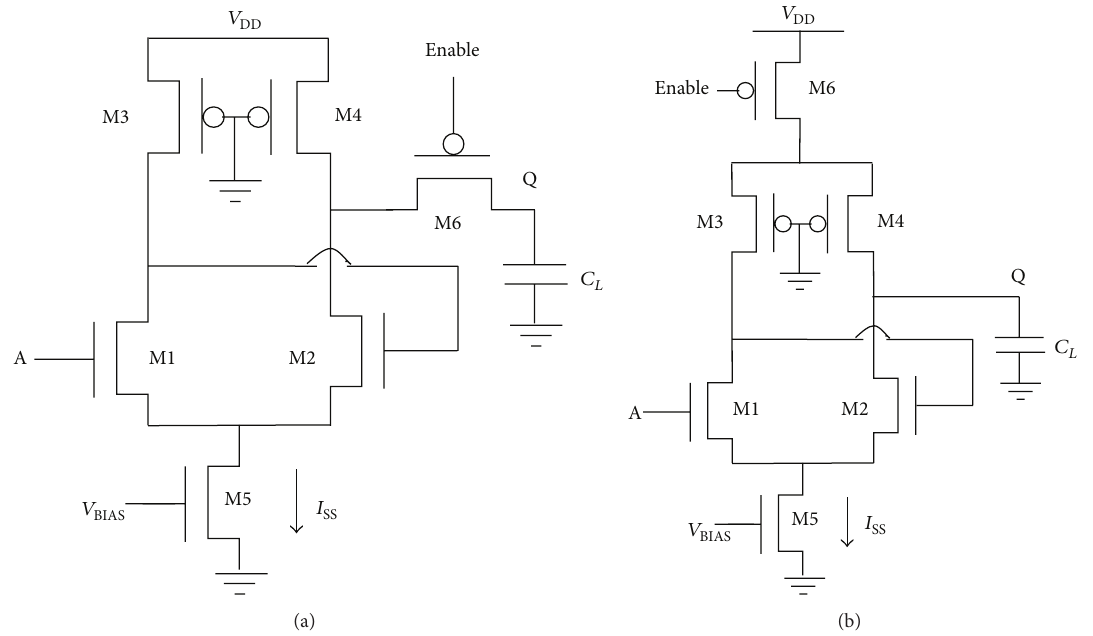
Figure 1: Available PFSCL tristate buffers [11]: (a) switch based; (b) sleep